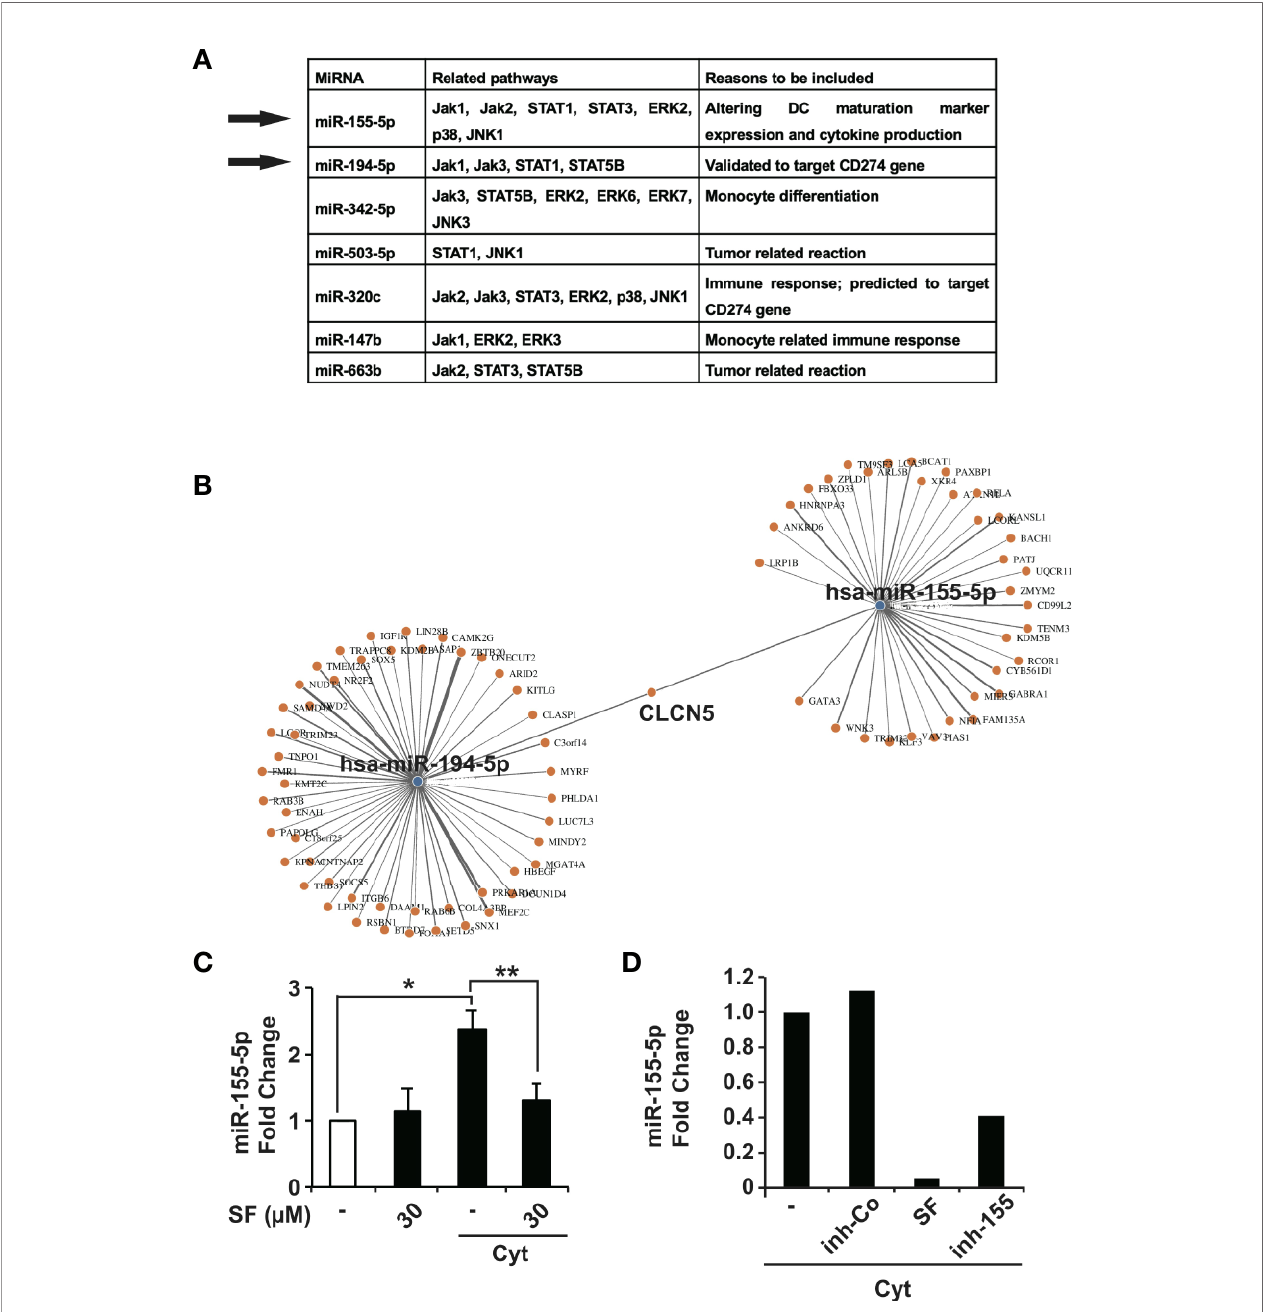
FIGURE 5 | miR-155-5p and miR-194-5p are accountable for the effect of sulforaphane on dendritic cells (DCs). (A) The prediction of miRNA targets using online resources (http://www.mirdb.org, http://mirtarbase.mbc.nctu.edu.tw) together with published data resulted in the identi fi cation of seven most promising candidates and selection of miR-155-5p and miR-194-5p. (B) Identi fi cation of joint and unshared target genes of miR-155-5p and miR-194-5p miRNAs. Target Mining option of the mirWalk online platform was used for miR-155-5p and miR-194-5p. Predicted probability was set to 0.9, TargetScan and MirDB were included. (C) Immature or mature (Cyt) monocyte-derived dendritic cells (MoDCs) were treated with vehicle control or 30 µM sulforaphane (SF) for 48 h, followed by RNA isolation, and RT- qPCR was used to assess the content of miR-155-5p in different RNA samples, n = 3 (D) MoDCs were pretreated with vehicle control (-) or 30 µM sulforaphane, lipotransfected with inhibition control (inh-Co) or miR-155-5p inhibitor (inh-155), then activated with cytokine cocktail (Cyt) for 48 h, followed by RNA isolation. RT- qPCR was used to assess the content of miR-155-5p in different RNA samples. *P ≤ 0.05, **P ≤